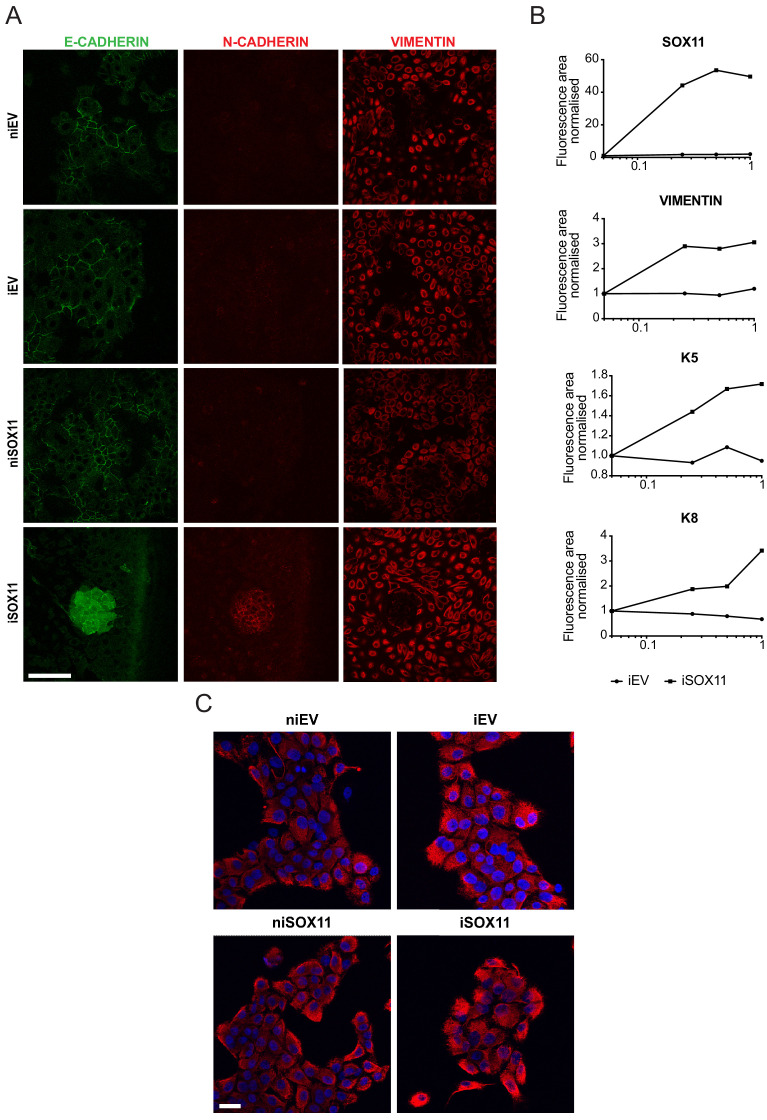
Inducible expression of SOX11 in DCIS.com cells leads to changes in expression of epithelial and mesenchymal markers.(A) E-CADHERIN, N-CADHERIN, VIMENTIN IF staining of EV or SOX11 cells grown in collagen induced with and without DOX treatment. Scale bar: 200 μm. (B) Fluorescence levels of iEV and iSOX11 stained by IF with SOX11, VIM, K5 and K8. The positively stained area for each protein was normalised by the area stained with DAPI. The results are shown normalised against niEV and niSOX11. (C) VIMENTIN IF and DAPI staining of EV or SOX11 cells induced with DOX and without DOX treatment. Scale bar: 200 μm. DOX: Doxycycline, IF: Immunofluorescence.